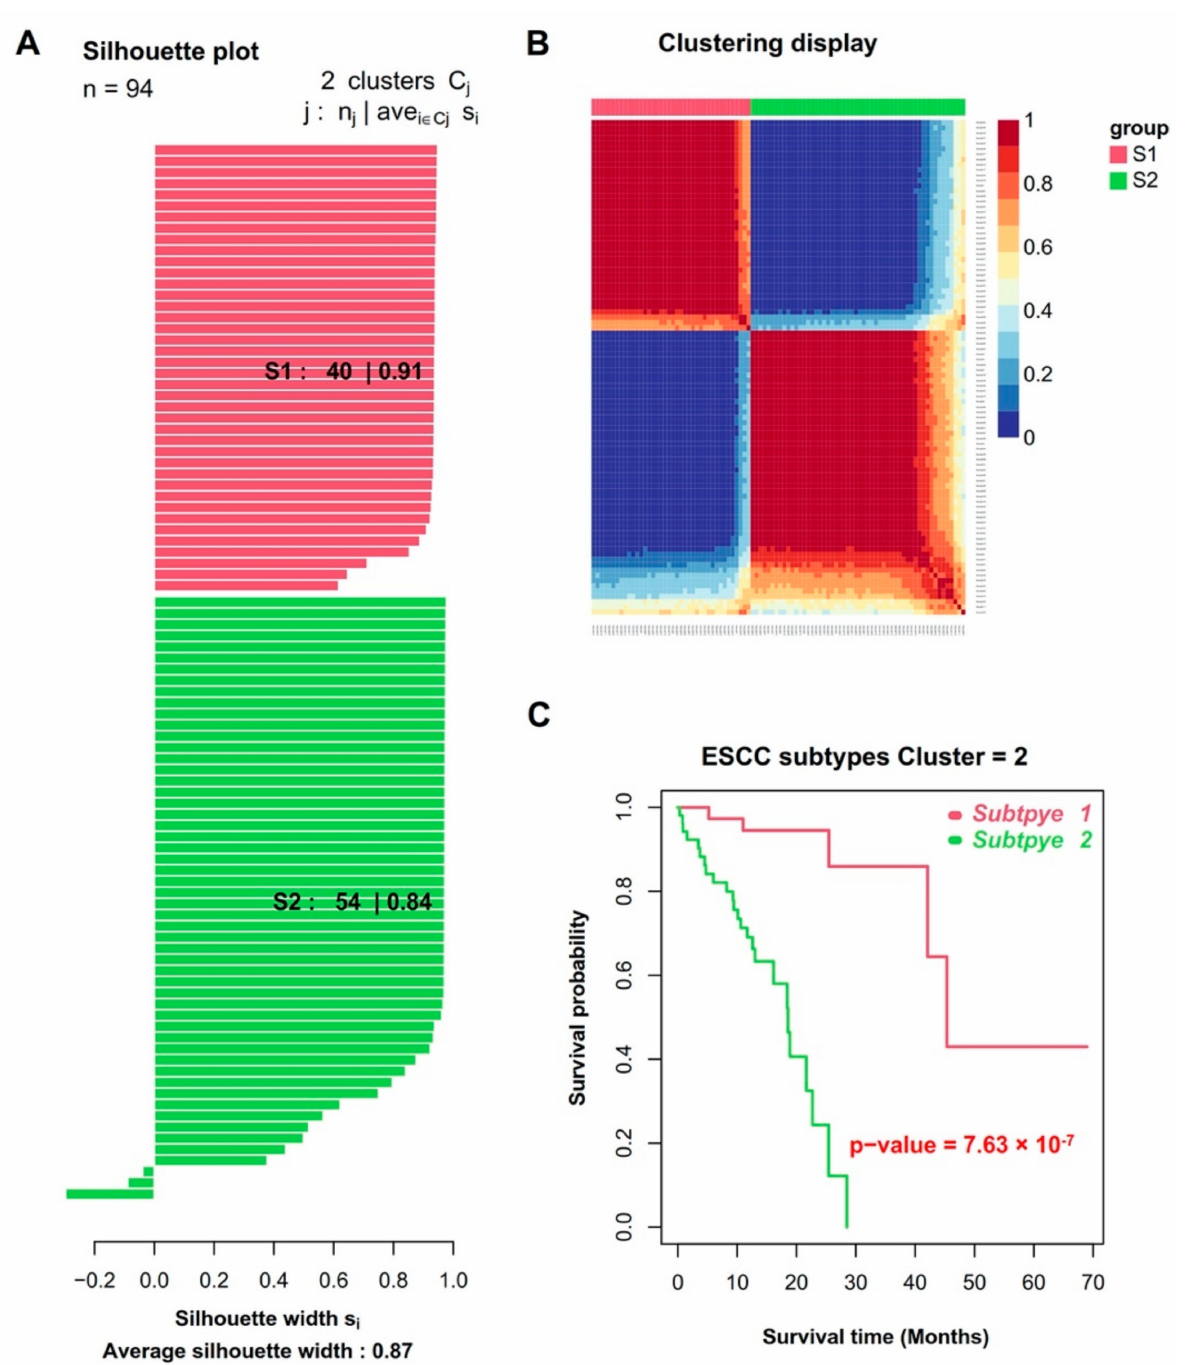
Figure 2. Identification of two subtypes using SNF-CC algorithm. ( A ) Silhouette width plots of the subtypes for k = 2. ( B ) Heatmap representation of the sample-to-sample fused network data sorted by cluster for k = 2. Sample similarity is represented by red (high similar) to blue (less similar) coloring inside the heatmap. ( C ) Kaplan–Meier curves comparing overall survival between S1 and S2